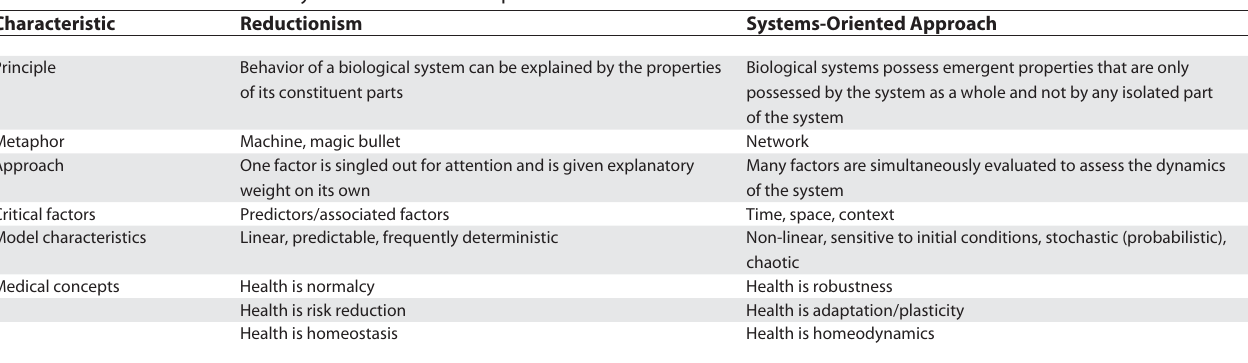
Table 1. Reductionism versus a Systems-Oriented Perspective